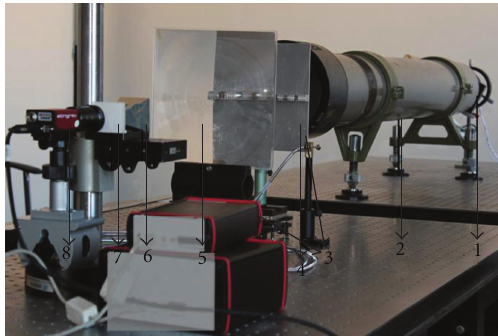
Figure 7: Physical map of indoor concentration test system. 1. LED source; filter, 2. collimator, 3. fiber spectrometer, 4. stop, 5. fresnel concentration system, 6. light funnel, 7. opal glass, and 8. CCD